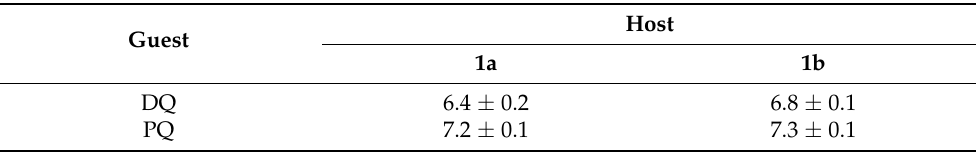
Table 6. Association constants of H-G complexes at 25 ◦ C, reported as log K . Paraquat, PQ, and diquat, DQ, are the guests, G, and the compounds 1a and 1b are the fluorescent hosts, H. The values were determined by Equation (3). Uncertainties are given as standard deviation.